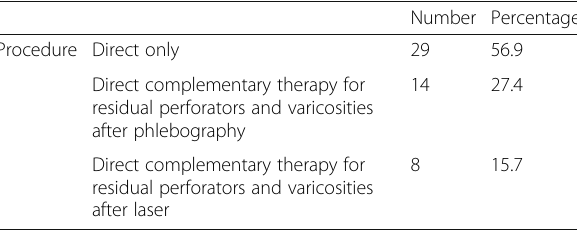
Table 4 The number and percentage of cases subjected